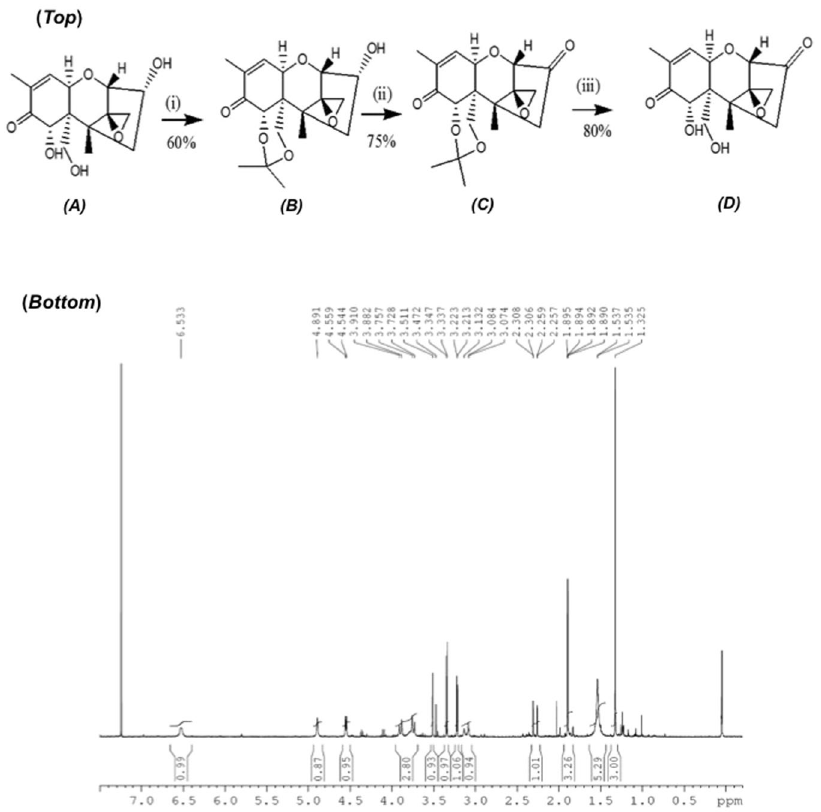
Figure 2. The chemical synthesis of 3-keto- DON and the retrieved proton ( 1 H) NMR spectra of the synthesized compound. ( Top ): Chemical synthesis of 3-keto- DON ( D ) encompasses protecting the 7,15-dihydroxyl groups of DON ( A ) by using 2,2-dimethoxypropane (i) before oxidizing the secondary hydroxyl (ii) in a later phase. The protecting-groups were removed later through a hydrolysis initiated with TFA (iii) to finally obtain the desired 3-keto- DON intermediate ( D ). ( Bottom ): The obtained chemical shifts of 1 H-NMR signals of the chemically synthesized 3-keto- DON are identical with previously published data for the same compound 10, 15 . A detailed discussion of the spectra is found within the results section. An overall yield close to 36% was achieved combined with purity levels close to